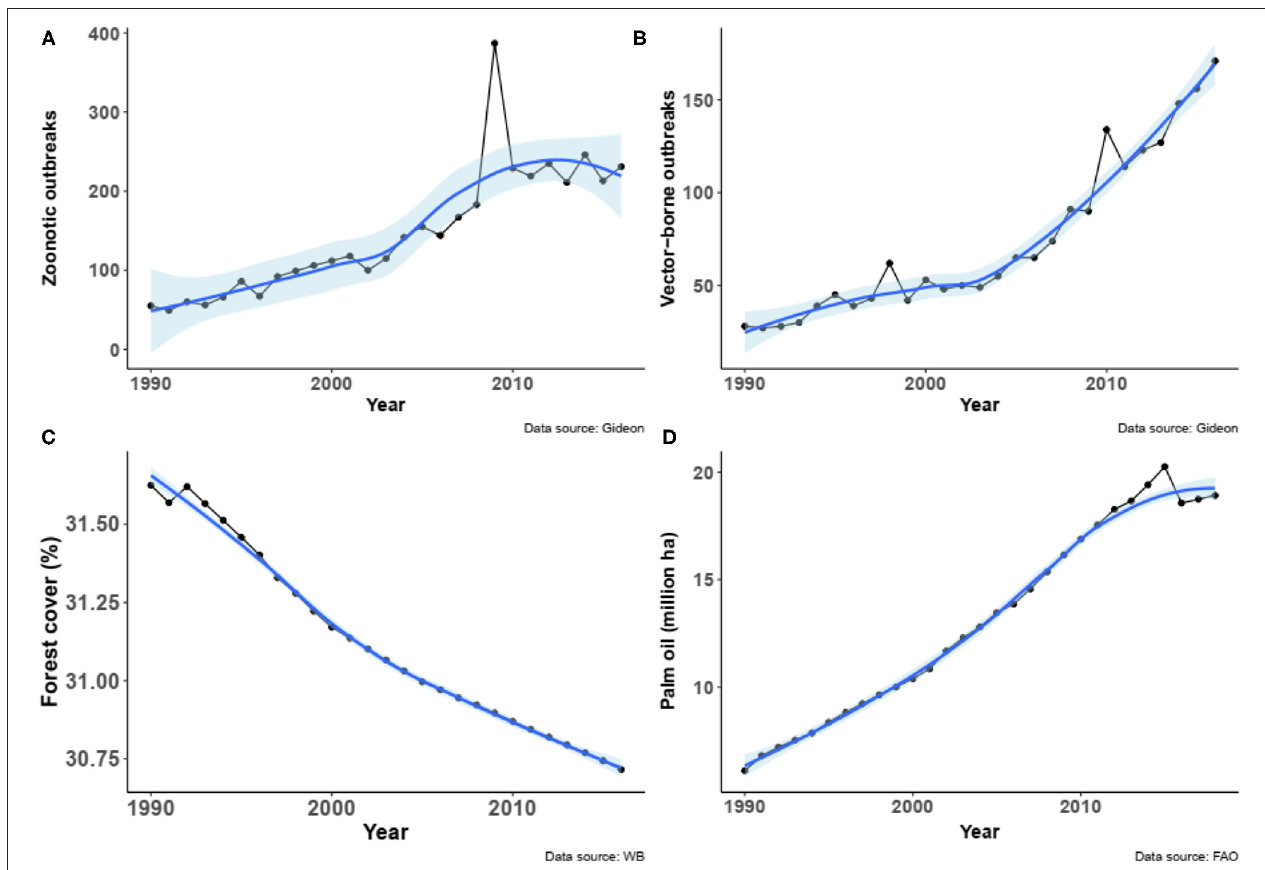
FIGURE 1 | (A) Number of outbreaks of zoonotic diseases worldwide from 1990 to 2016 (data obtained from GIDEON). ( B) Number of outbreaks of vector-borne diseases worldwide from 1990 to 2016 (data obtained from GIDEON). (C) Global change in forest cover (in share of global land) from 1990 to 2016 (data obtained from World Bank). (D) Relationship between the number of outbreaks of zoonotic diseases worldwide and the change in forest cover from 1990 to 2016. (E) Relationship between the number of outbreaks of vector-borne diseases worldwide and the change in forest cover from 1990 to 2016. Fitted smooth regressions (in blue) with confidence intervals (in light blue) are